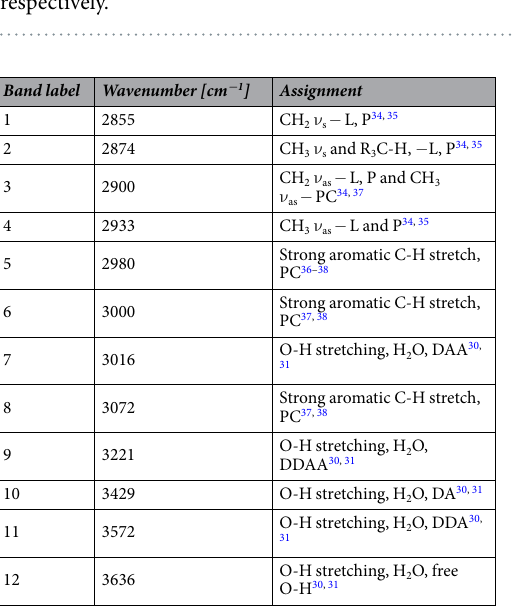
Table 2. Main Raman bands observed in the spectra collected during the A6 cells analysis and their assignments (bands numbered according to Fig. 5). P = proteins, L = lipids, PC = polycarbonate, ν s = symmetric stretching, ν as = asymmetric stretching.